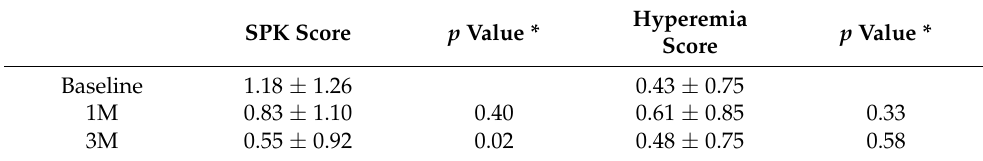
Figure 1. Mean intraocular pressure at baseline and at 4 and 12 weeks. There was no significant difference observed in the mean IOP as compared to the baseline. Table 2. SPK and hyperemia score.